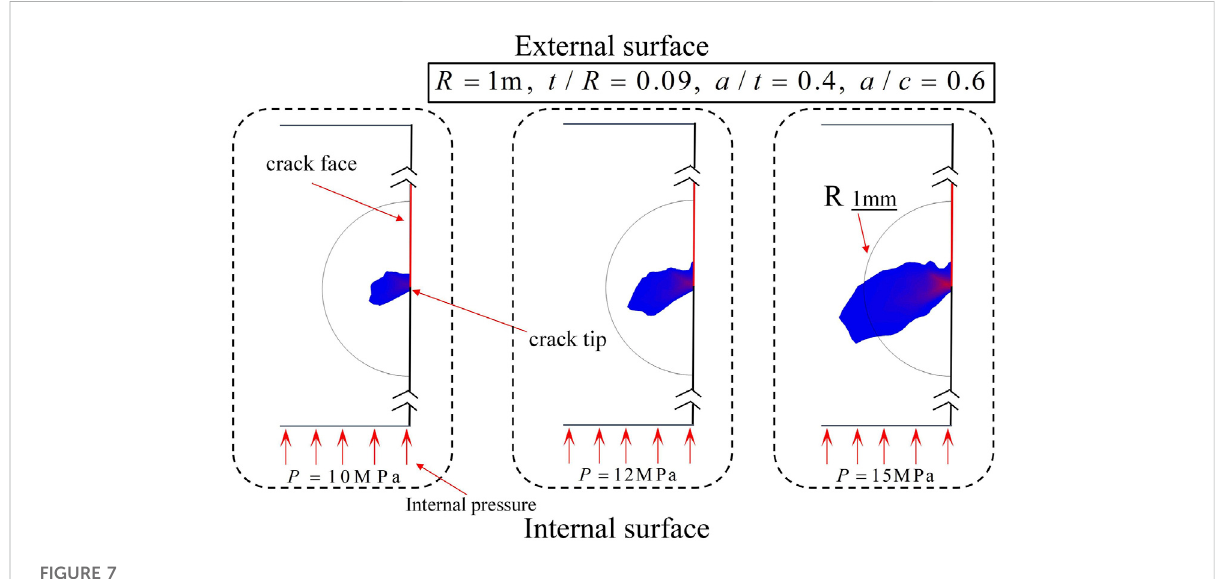
FIGURE 7 Plastic zone area at the crack tip under different internal pressure.